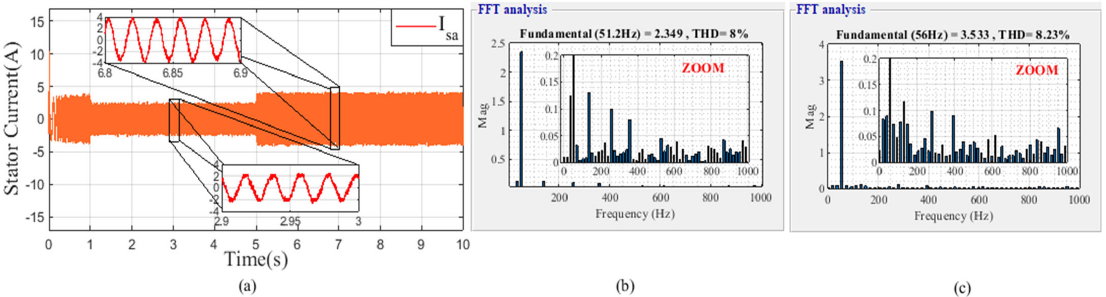
Figure 43. Performance in healthy state of IM with ANN ‐ DTC control: ( a ) Stator current and ( b ) THD at no ‐ load and ( c ) THD with load (5 Nm).